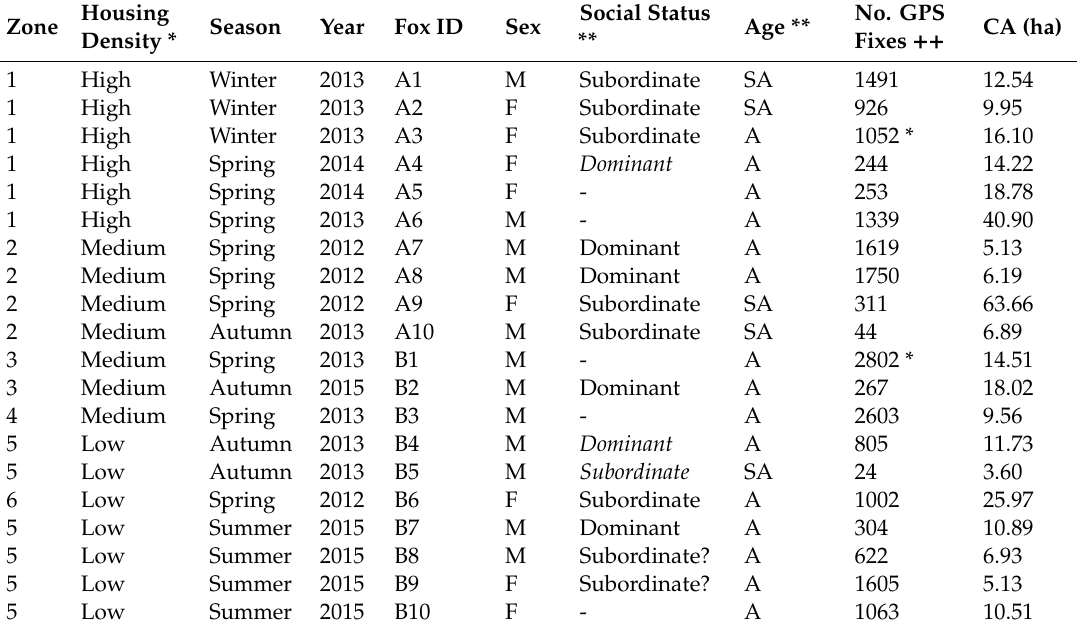
Table 2. Site and individual characteristics of 20 foxes GPS-tracked in Brighton and Hove in six residential zones with varying housing density, from April 2012 to September 2015. * Low < 30; medium = 30–60; high > 60 usual resident households per hectare. ++ truncated at asymptote except for * where asymptote not reached. ** Age and social status were estimated from a combination of month trapped, tooth wear, weight, body condition, and evident breeding status (see SI Table S1 for details). For A4, B4, and B5, additional behavioral observations were available to confirm social status